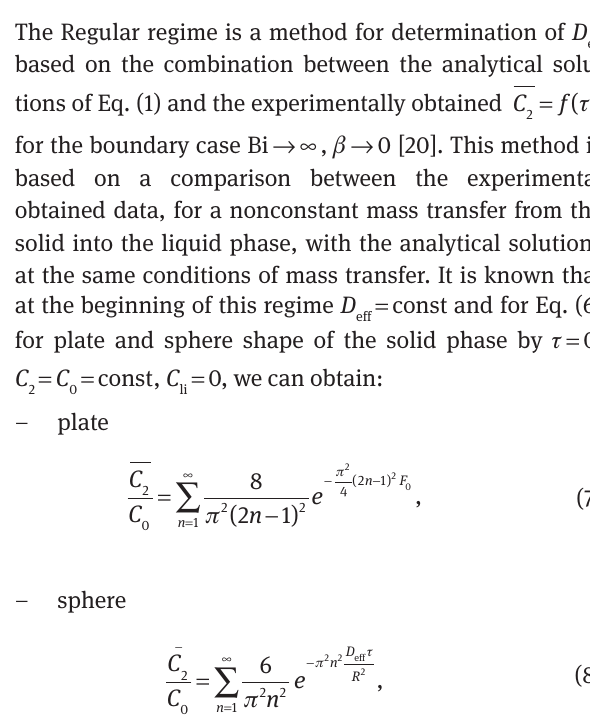
Figure 1: Dependence of tobacco concrete liquid phase concentra- tion on the agitation rate at t = 20 ° C; ζ = 0.04 m 3 /kg and solvent